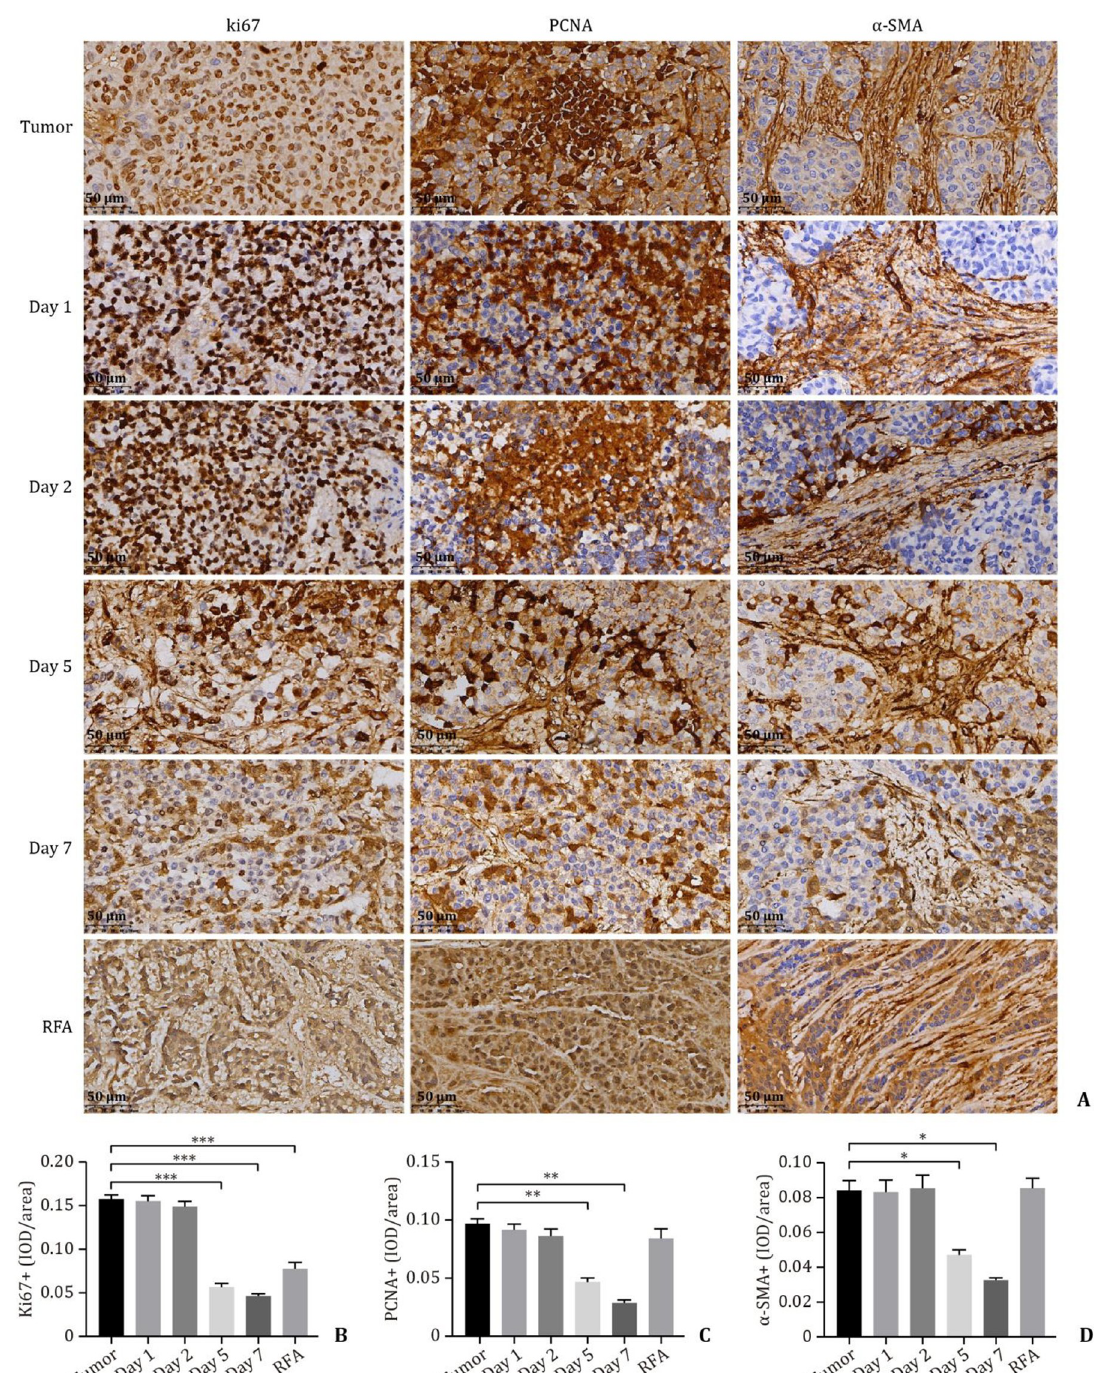
Fig 6. Immunohistochemistry of Ki67, PCNA, and α -SMA was performed on the VX2 tumor rabbit model at days 1, 2, 5 and 7 after nsPEF ablation. After 5 days RFA ablation, immunohistochemistry of Ki67, PCNA and α -SMA was performed on the rabbit VX2 liver tumor model. A : Representative immunohistochemical staining of Ki67, PCNA and α -SMA in liver sections from the different groups. B-D : Quantitative analysis of Ki67, PCNA and α -SMA staining in the different groups. Data are expressed as the mean ± SD. � P < 0.05; �� P < 0.01; ��� P < 0.001. PCNA: proliferating cell nuclear antigen; α -SMA: alpha-smooth muscle actin; nsPEFs: nanosecond pulsed electric fields; RFA: radiofrequency ablation.